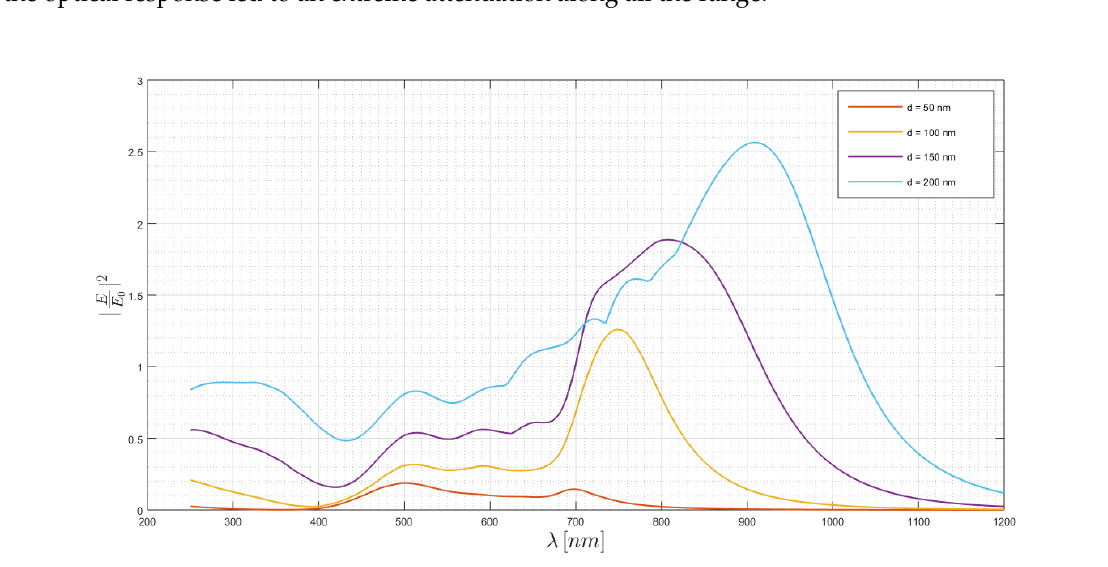
Figure 7. Hole diameter sweep on the silver